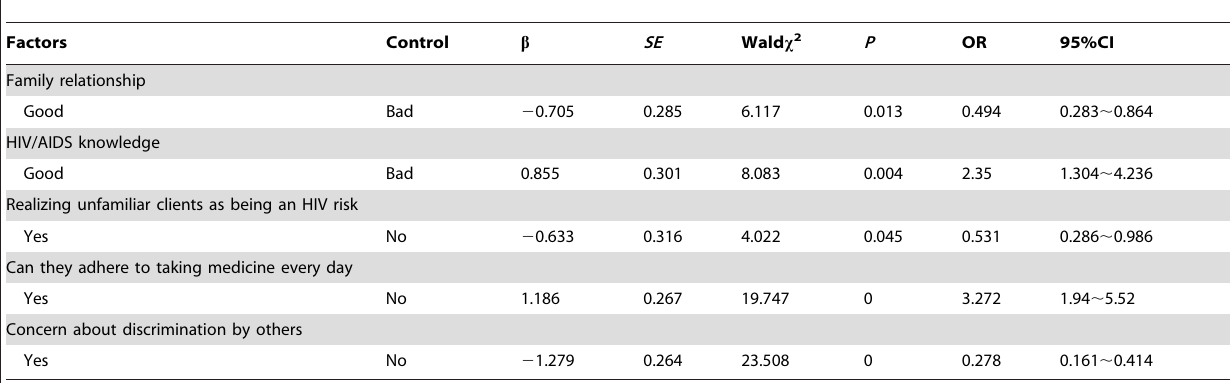
Table 5. Logistic regression analysis of intention to participate in a clinical trial.